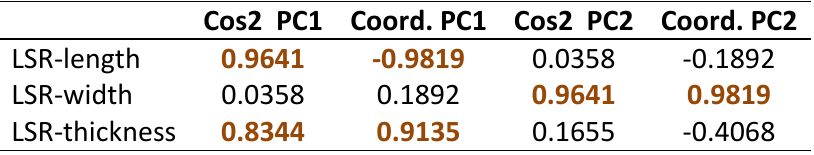
Table 10. Coordinates of the two PCs and their cos 2 from the PCA6 presented in Figure 17. Variables with highest contribution and quality of representation on the PCs are shown in